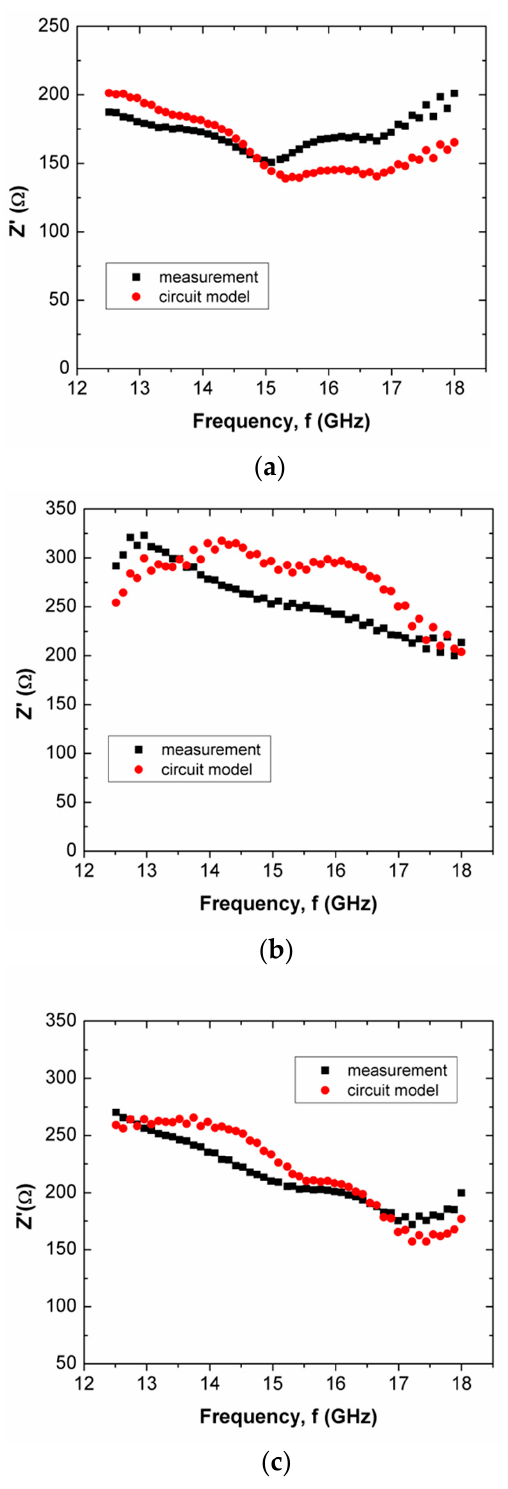
Figure 7. Comparison between measured and simulated Z’ of scaffold composites with ( a ) composition A, ( b ) composition B and ( c ) composition C, at Ku-band.